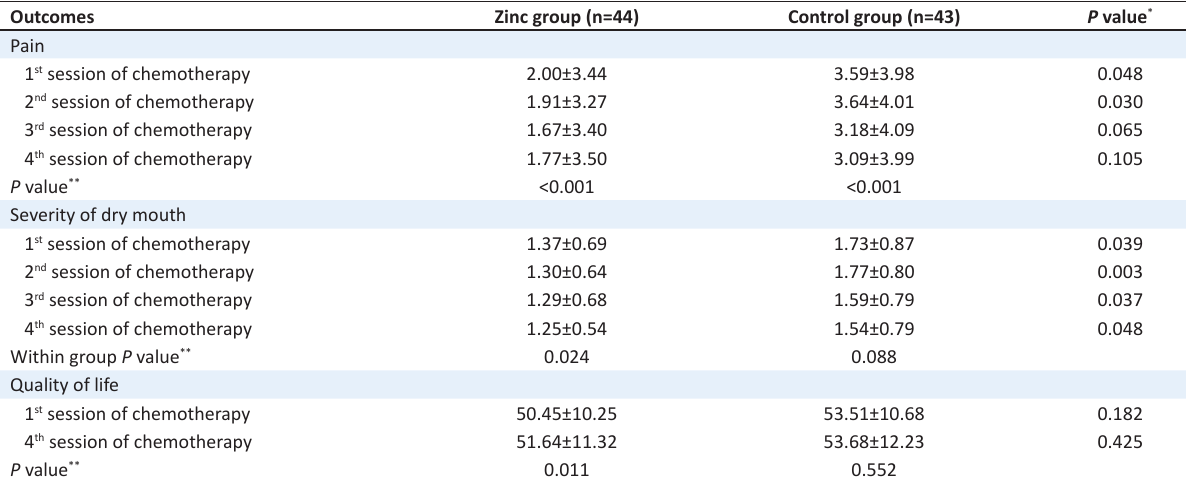
Table 3. The patients’ severity of pain, dry mouth, and quality of life in the two groups